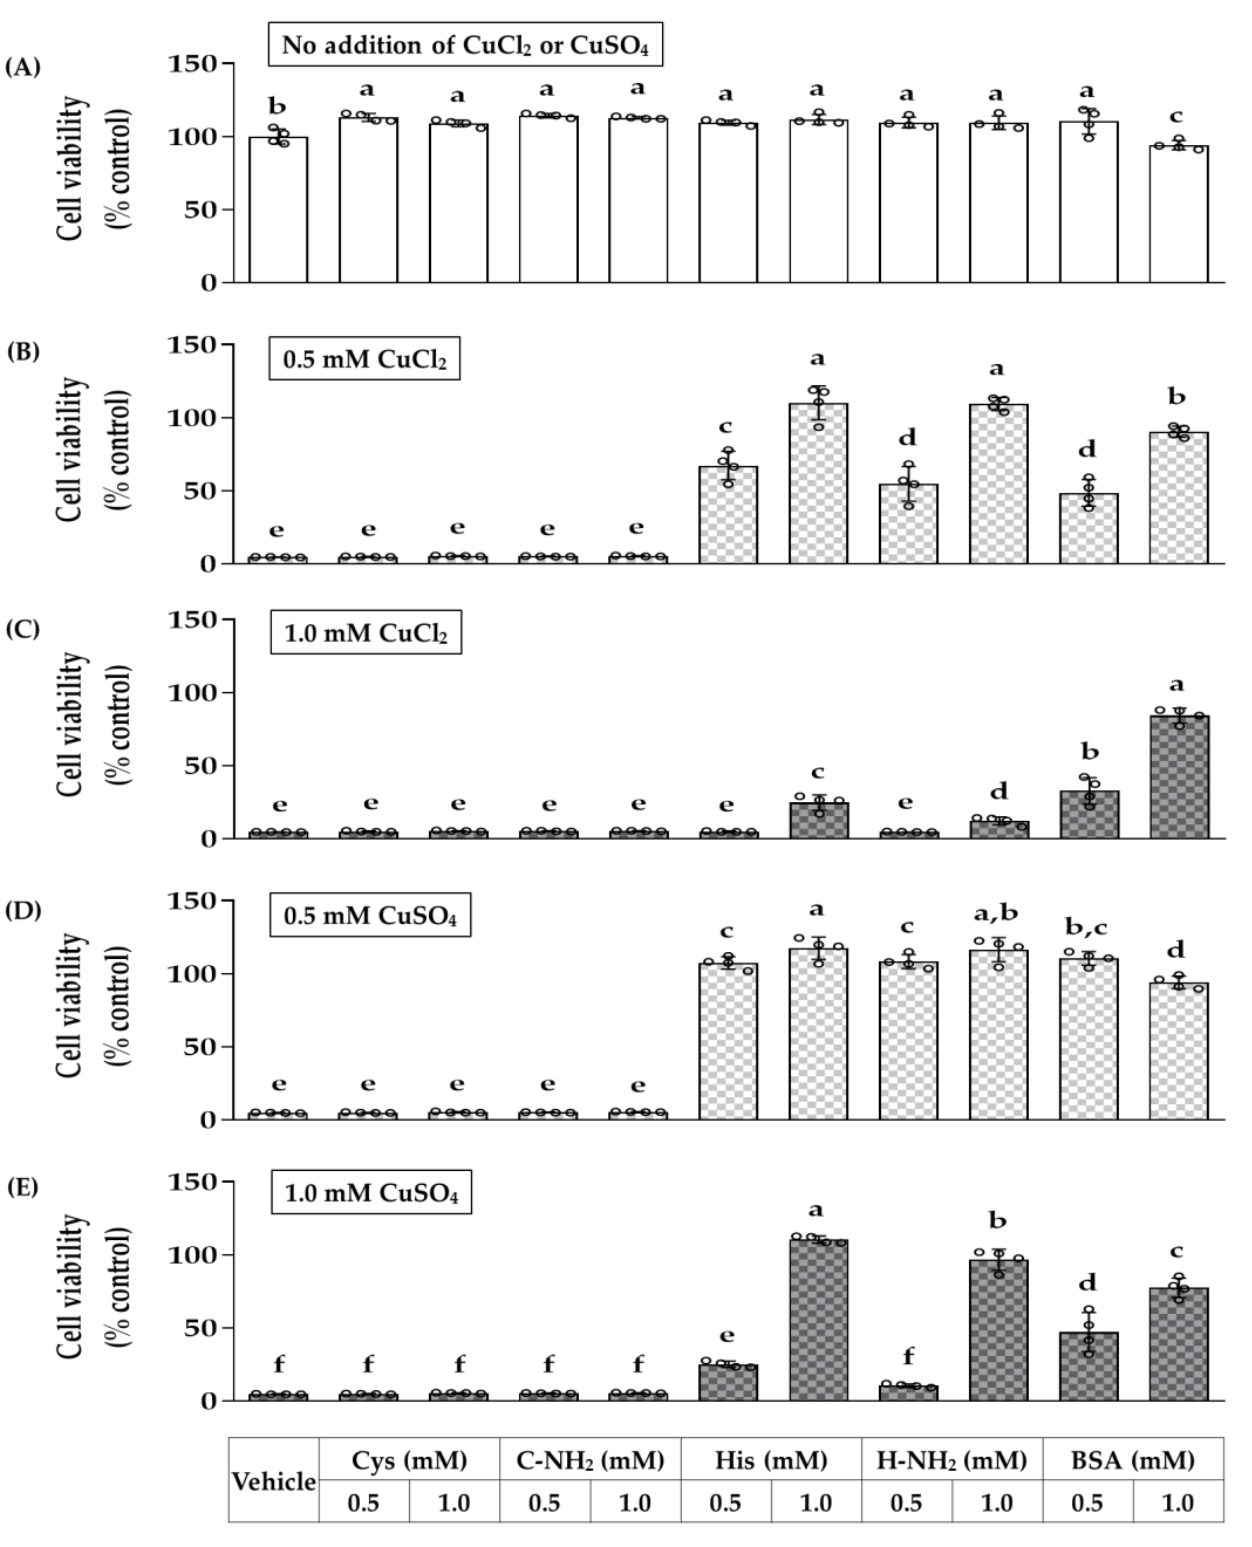
Figure 9. Effects of cysteine, cysteinamide, histidine, histidinamide, and BSA on the viability of HaCaT cells exposed to different Cu(II) salts. Cells were treated with a test material at varying concentrations with no addition ( A ) or the addition of 0.5 mM CuCl 2 ( B ), 1.0 mM CuCl 2 ( C ), 0.5 mM CuSO 4 ( D ), or 1.0 mM CuSO 4 ( E ) for 48 h. Cell viability is presented as % of the control group (mean ± SD, n = 4). Different lowercase letters (a–f) indicate significantly different means at the p < 0.05 level.